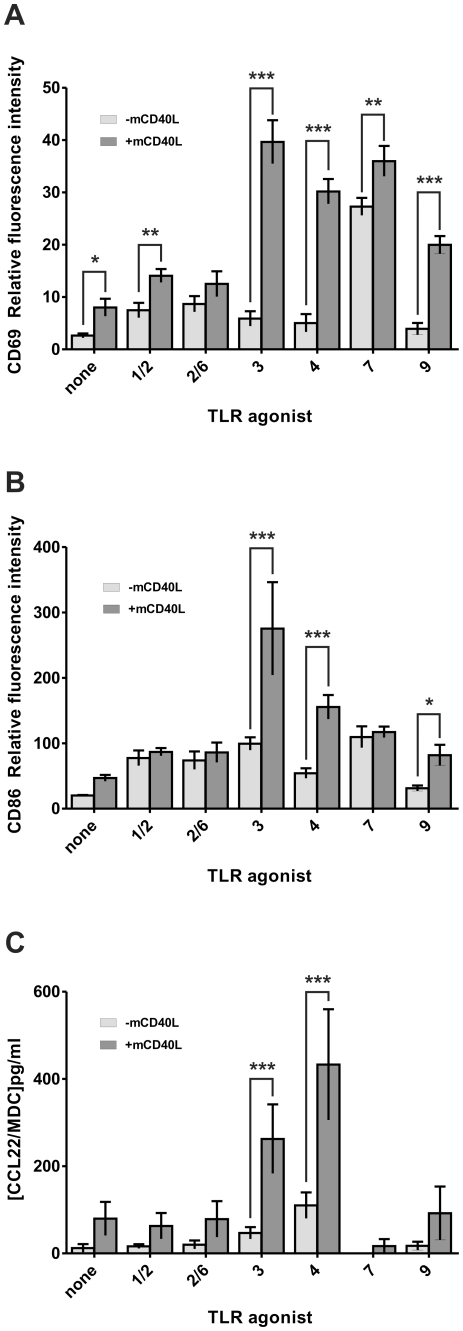
B cell activation induced by TLR agonists in association with mCD40L.Purified B cells were cultured with TLR1/2 agonist Pam3CSK4 (250 ng/mL), TLR2/6 agonist Pam2CSK4 (50 ng/mL), TLR3 agonist poly (I:C) (10 µg/mL), TLR4 agonist LPS (10 µg/mL), TLR7 agonist R848 (1 µg/mL) or TLR9 agonist ODN 2395 (200 nM) alone (light gray bars) or in the presence of 0.6 µg/mL mCD40L (dark gray bars). After 24 h, expression of activation markers CD69 (A) or CD86 (B) were measured by flow cytometry. Results are expressed as mean relative fluorescence intensity. Mean values ± SD of three independent experiments are shown. (C) CCL22/MDC levels were measured in cell culture supernatants by ELISA after 48 h. Results are expressed in pg/mL and represent means ± SD of three independent experiments. *p<0.05, **p<0.01, ***p<0.001.